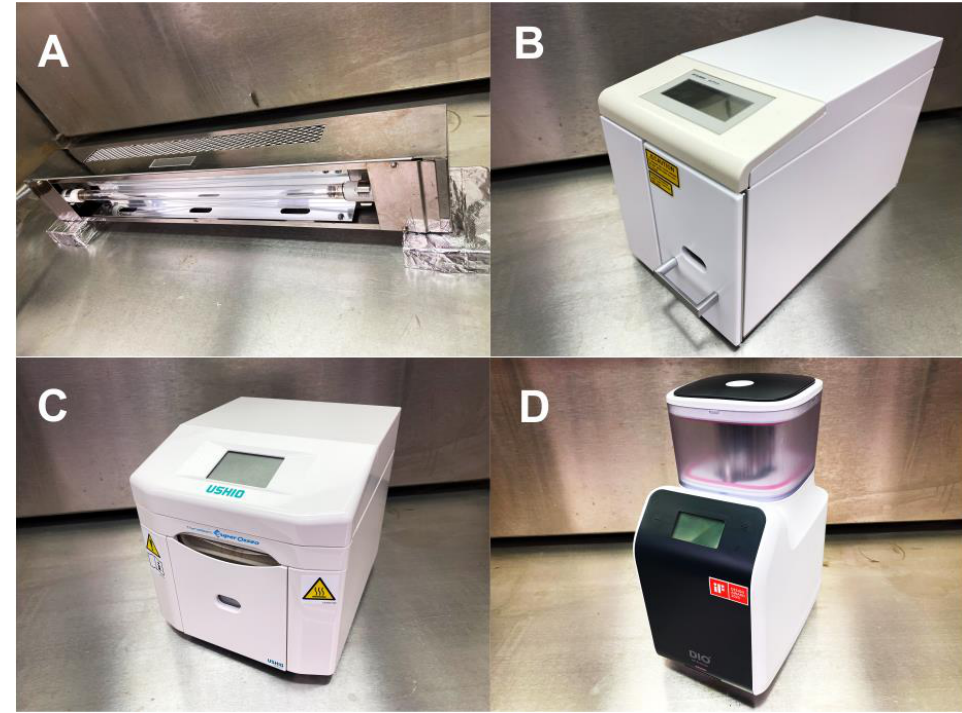
Figure 11. Photographs of UV devices used in this study. ( A ) UVC device (UVC). ( B ) High-energy UVC (HUVC). ( C ) UV device with a proprietary protocol (PUV). ( D ) 172 nm vacuum UV (VUV).